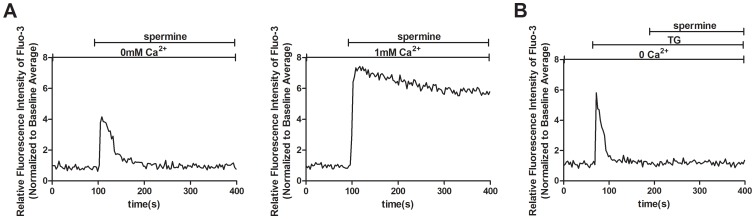
CaSR activation induces intracellular Ca2+ release.[Ca2+]i dynamics were monitored by Fura-3 fluorescence methods. (A) Representative traces showing that 3 mM spermine induces an increase in [Ca2+]i even in the absence of extracellular Ca2+(left). Cells were bathed in Ca2+-free solution followed by addition of 3 mM spermine. In the presence of extracellular 1 mM Ca2+, addition of 3 mM spermine evokes a rapid peak of [Ca2+]i and a subsequent sustained increase in [Ca2+]i (right). (B) Depletion of internal Ca2+ stores by 1 µM thapsigargin (TG) abolishes the 3 mM spermine-induced [Ca2+]i signaling in the absence of extracellular Ca2+. Cells bathed in Ca2+-free solution were stimulated with 1 µM TG, and then, 3 mM spermine was added to the bath solution. The results were from at least three independent experiments, and each experiment measured 20 to 40 cells.